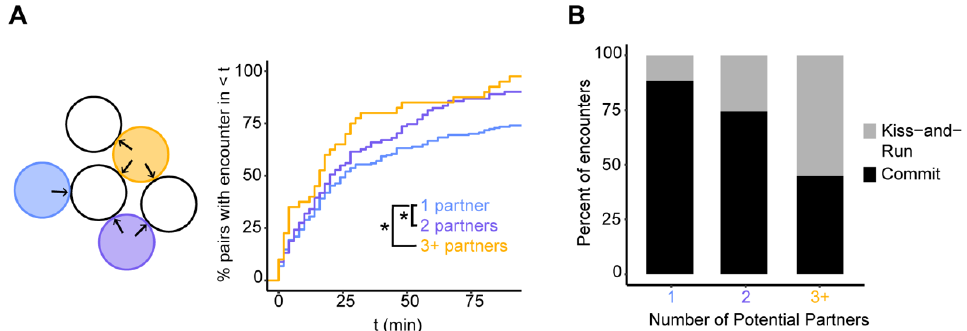
Figure 2. Polarity site encounters in sparse versus crowded conditions. ( A ) Left: Schematic of cells with different numbers of potential partners in a mating mixture. Potential opposite MAT partners for each colored cell are indicated by black arrows (the blue cell has one potential partner, the purple cell has two potential partners, and the yellow cell has three potential partners). Right: Cumulative distributions of the time to polarity site encounter for wild-type cells (DLY20626 and DLY20627) touching the indicated number of potential mating partners ( n ≥ 40 pairs) (* = KS test p < 0.05). ( B ) Percent of encounters that result in commitment or kiss-and-run ( n ≥ 58 encounters) for cells with the indicated number of potential mating partners.